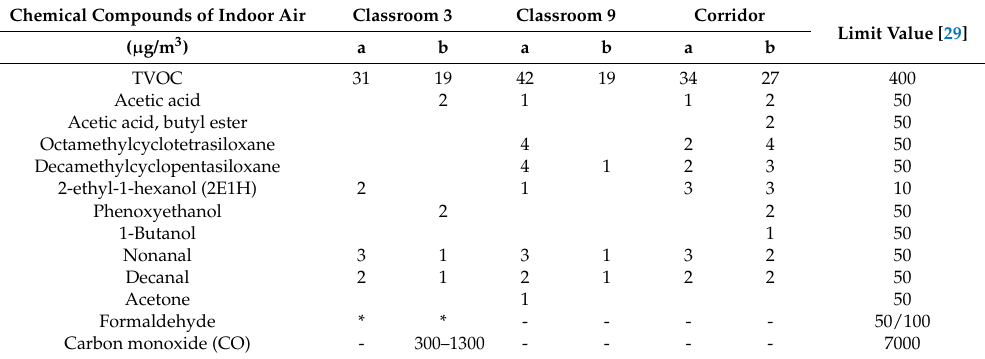
Table 5. TVOC, VOCs (concentrations over 1 µ g/m 3 ), formaldehyde, and CO before (a) and after (b) ventilation intervention.